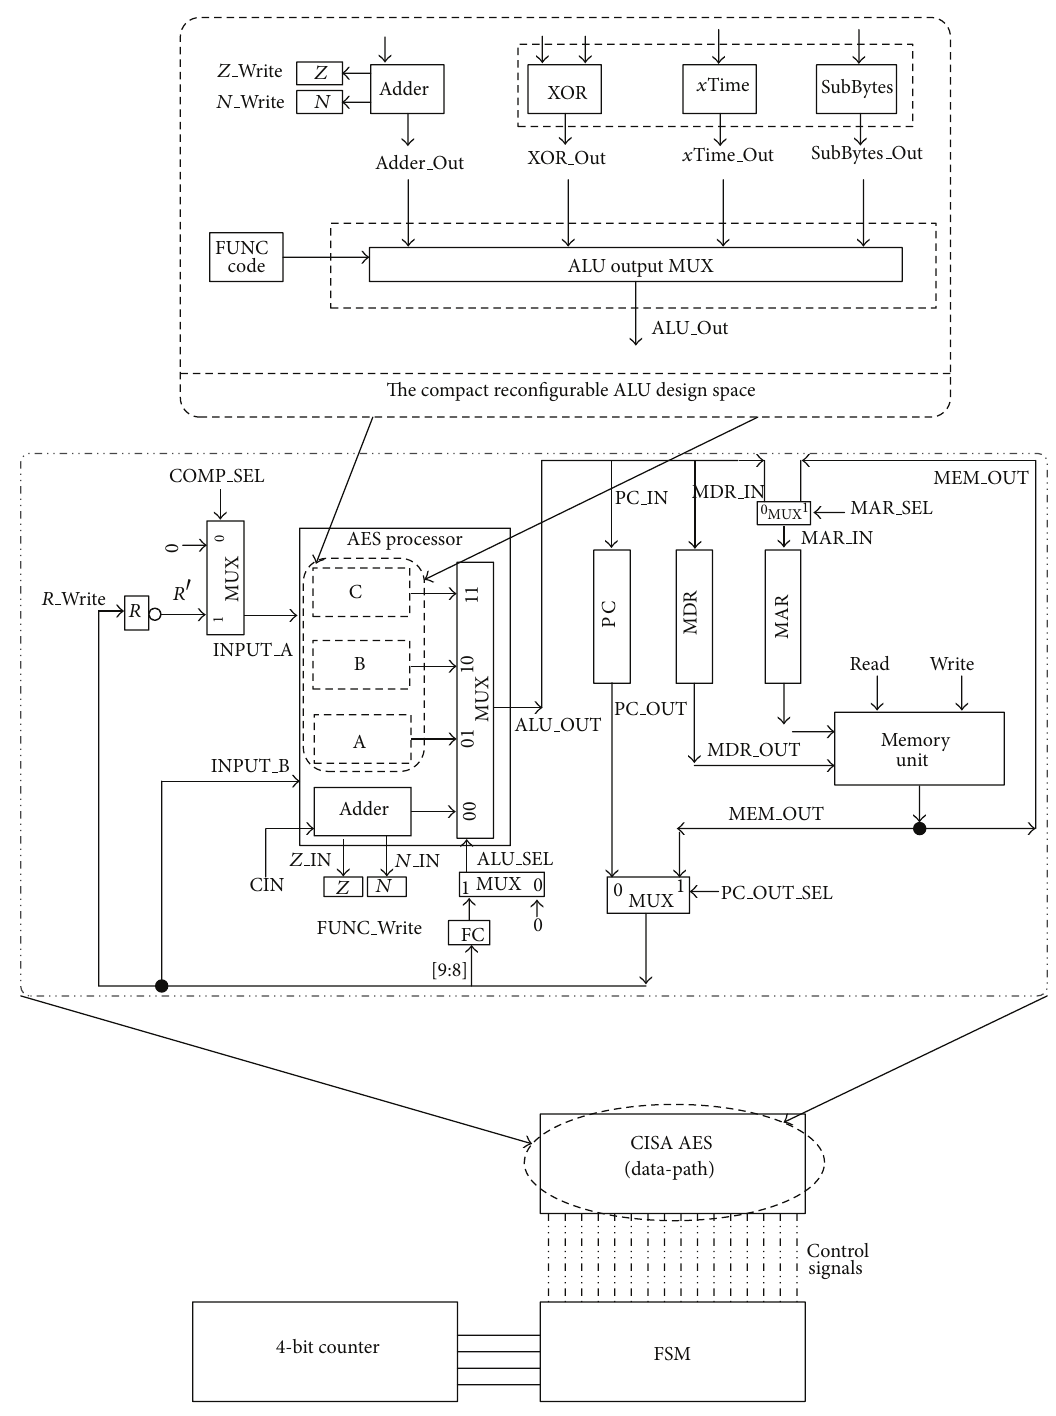
Figure 17: The overview of CISA von-Neumann architecture data-path with a programmable ALU